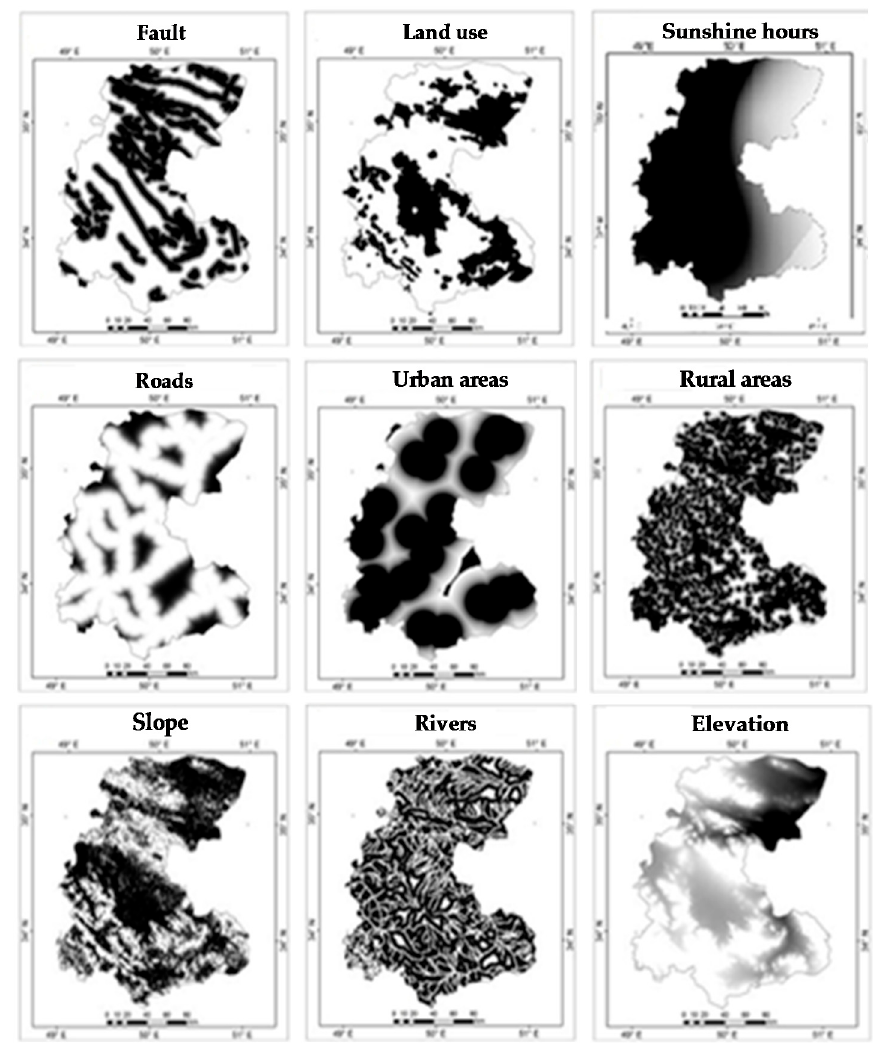
Figure 4. The restricted areas eliminated by Boolean model.